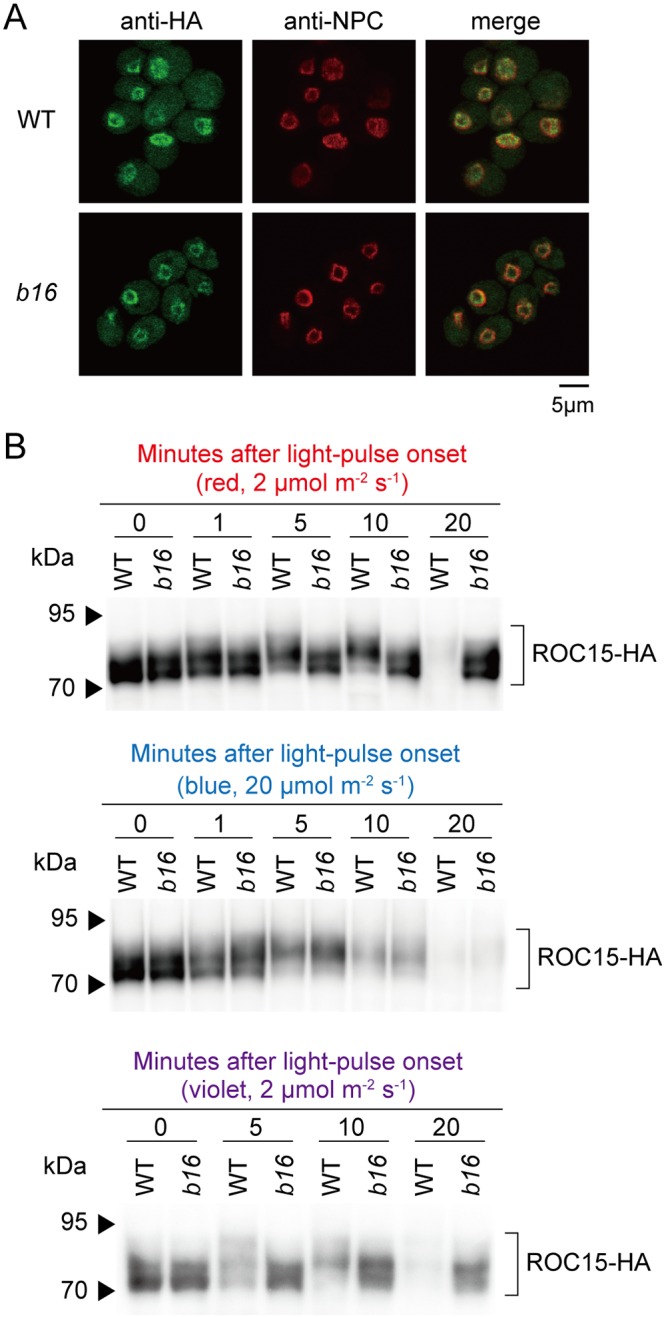
Subcellular localization and phosphorylation of ROC15.The b16 strain (mt+) was genetically crossed with the ROC15-HA strain (mt-). A progeny harboring b16 mutation and ROC15-HA transgene was selected by spot tests for antibiotic resistance and genomic PCRs. The hygromycin-resistance is genetically linked to b16 (see S5 Fig). LD-synchronized cultures of the progeny in HS liquid medium were used. (A) Cells were harvested at midnight and subjected to immunocytochemistry. The nuclear membrane was counterstained using an antibody against the nuclear pore complex (NPC). Photographs obtained under the same settings of microscope and detector are shown. (B) Cells were exposed to a 0.5 min pulse of red (660 nm, 2 μmol∙m-2∙s-1), blue (470 nm, 20 μmol∙m-2∙s-1), or violet light (405 nm, 2 μmol∙m-2∙s-1) at midnight, and total protein extracts were subjected to Western blot analysis.